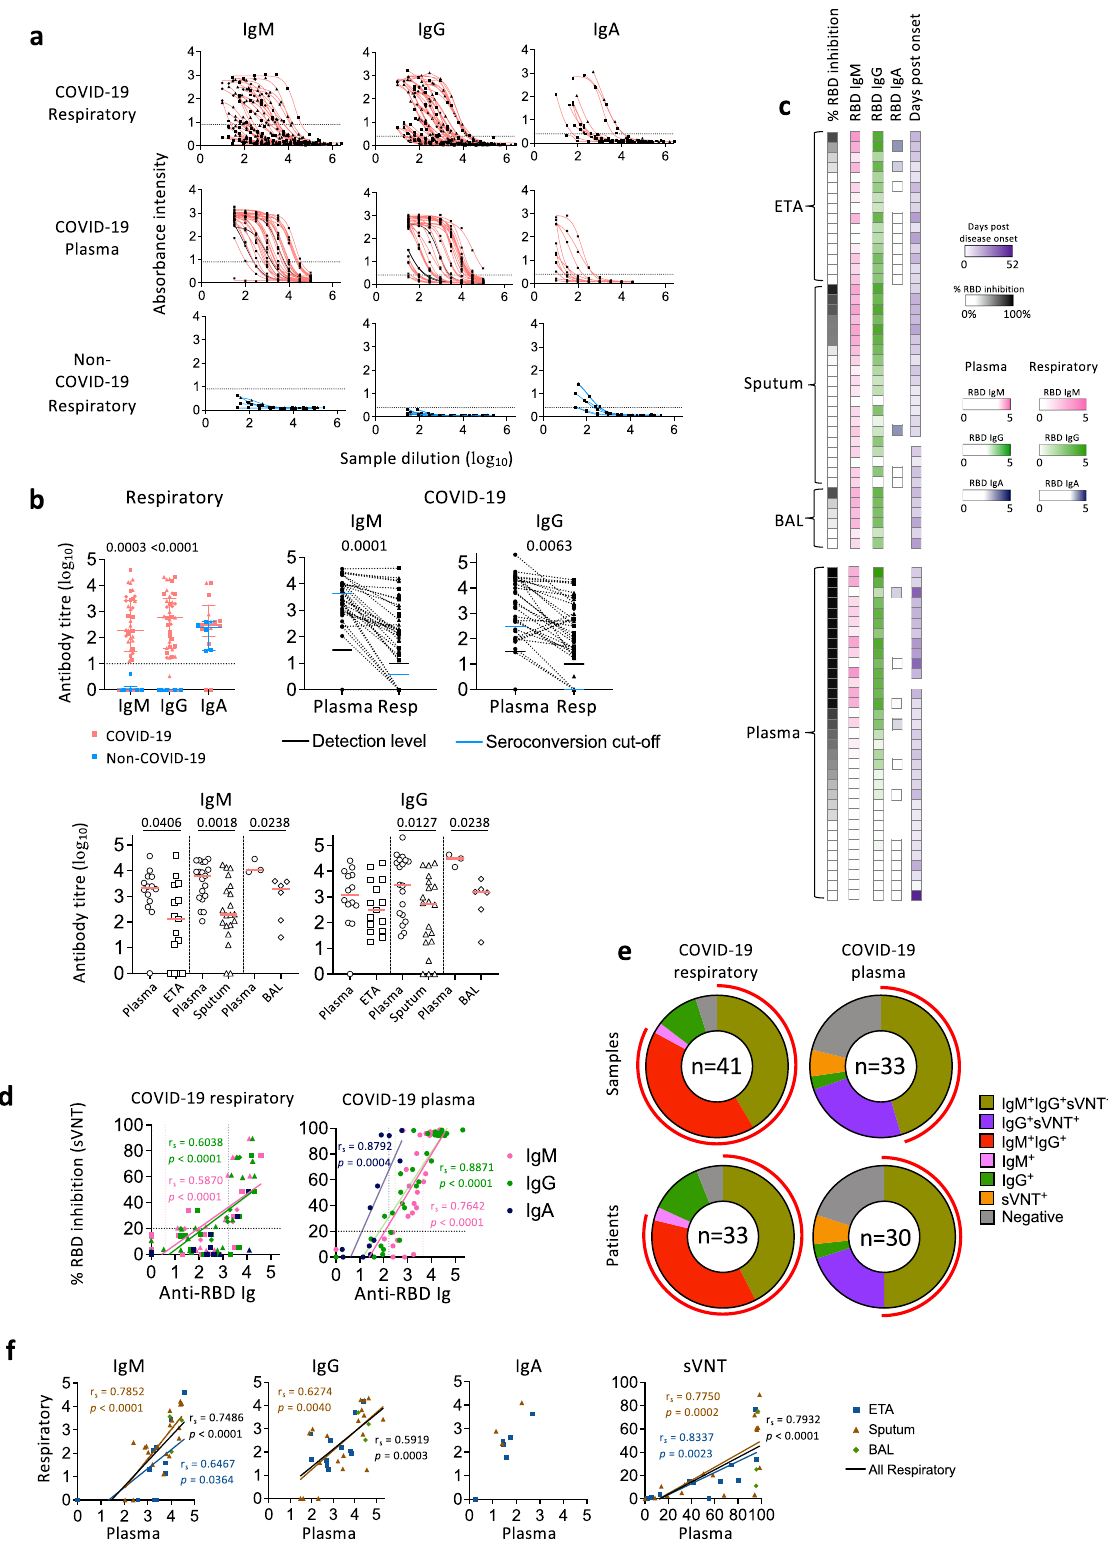
respiratory specimens of COVID-19 patients, samples underwent multi-parameter fl ow cytometry and analysis using the Spectre R package 26 . Cells were clustered using Flow Self-Organizing Map (FlowSOM) 27 and plotted using Fast Interpolation-based t-dis- tributed Stochastic Neighbour Embedding (FIt-SNE) 28 . Two fl ow cytometry panels were used to ensure accurate pro fi ling